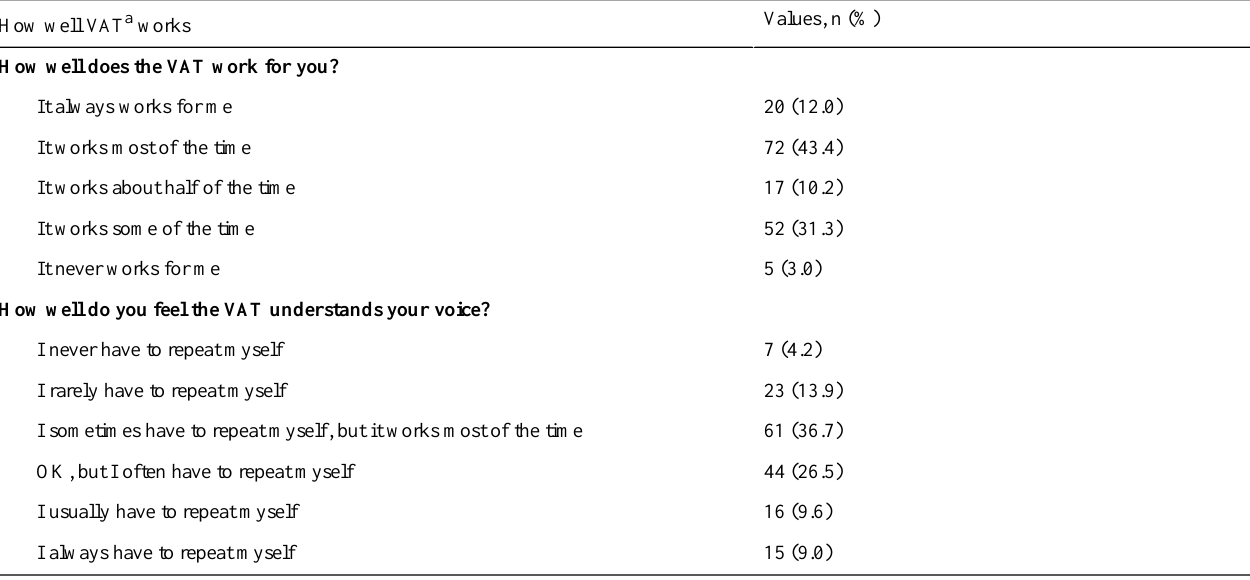
Values, n (%)How well VAT a works